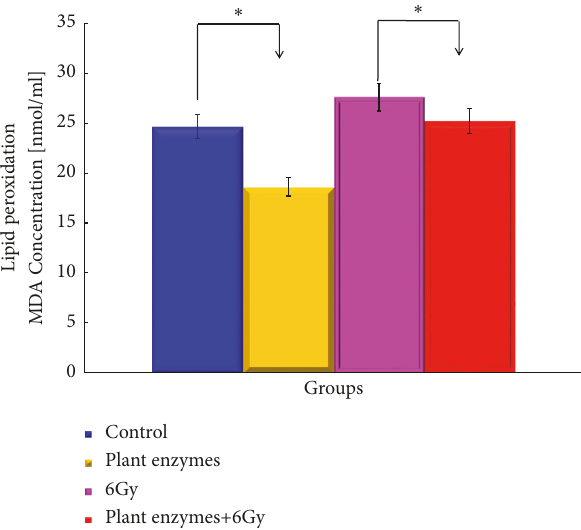
Figure 4: The effects of the Validux Plant Enzyme of repeated administration on the levels of lipid peroxidation (MDA concen- tration) in mice with prostate cancer. Changes in the levels were obtained. The results measured represent ± SD for 7-8 mice. MDA concentration (nmol/ml/mouse) was also measured. ∗ Significantly different from the Validux Plant Enzyme vs. control group and Validux Plant Enzyme +6Gy vs. 6Gy ( P < 0.05